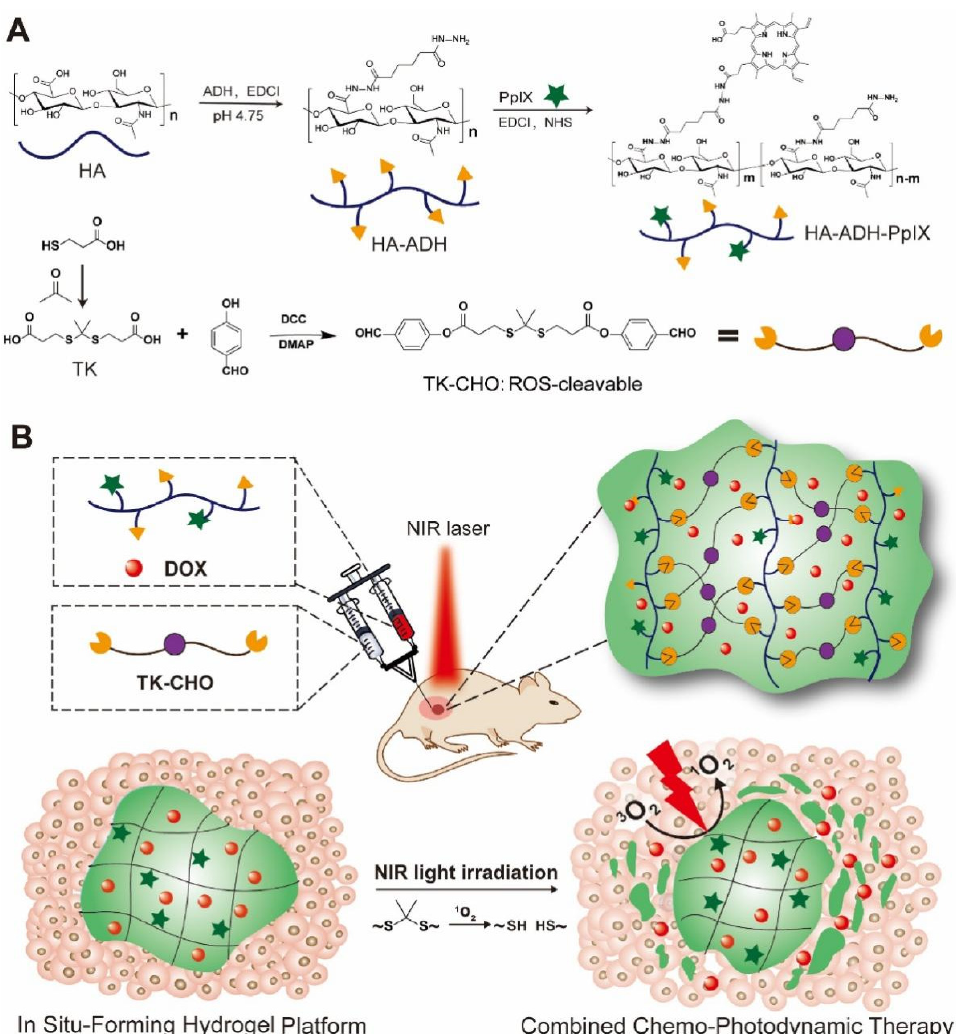
Figure 9. (A) Schematic illustrations for the synthesis of formulation of the ROS-sensitive hyaluronic acid hydrogel and (B) its application for combinational antitumor PDT-chemotherapy. Reprinted with permission from [231].